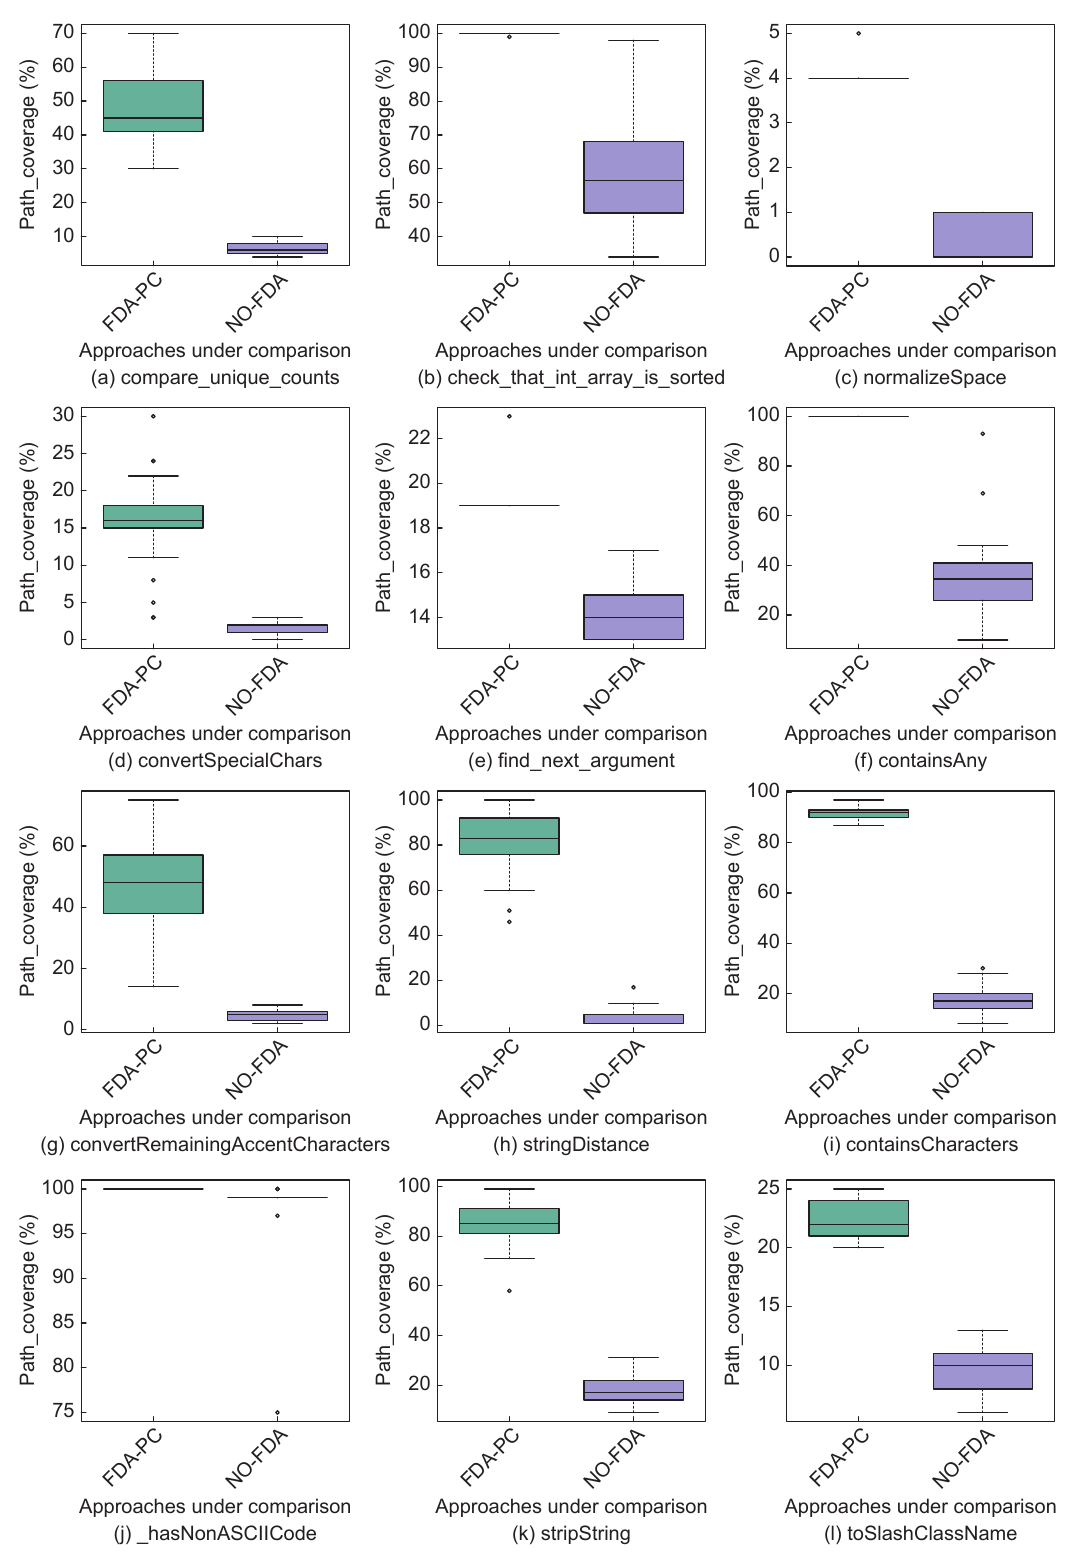
Fig. 8 Box plots for compare_unique_counts, check_that_int_array_is_sorted, normalizeSpace, convertSpecialChars, find_next_argument, containsAny, convertRemainingAccentCharacters, stringDistance, containsCharacters, _hasNonASCIICode, stripString, and